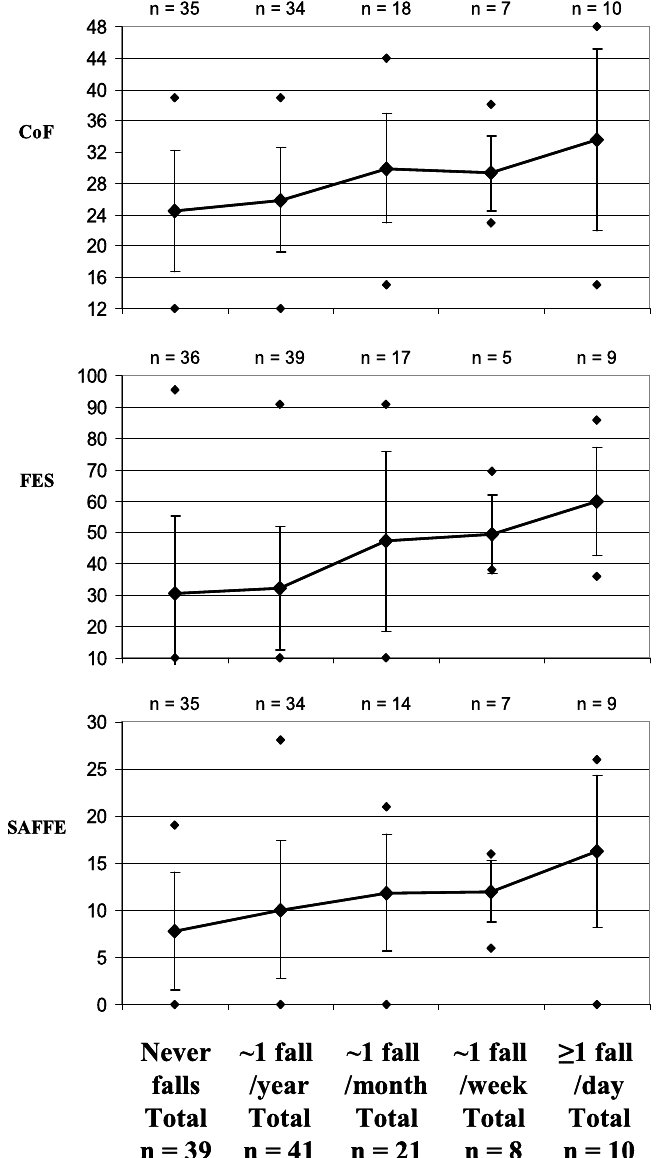
Fig. 1. Mean ( ± SD) fear of falling (FoF) values vs. frequency of falling. Higher values indicate greater FoF on all measures. Points above and below mean line indicate maximum and minimum values in each group. CoF: Consequences of Falling Scale; FES: Falls Ef fi cacy Scale, SAFFE: Survey of Activities and Fear of Falling in the